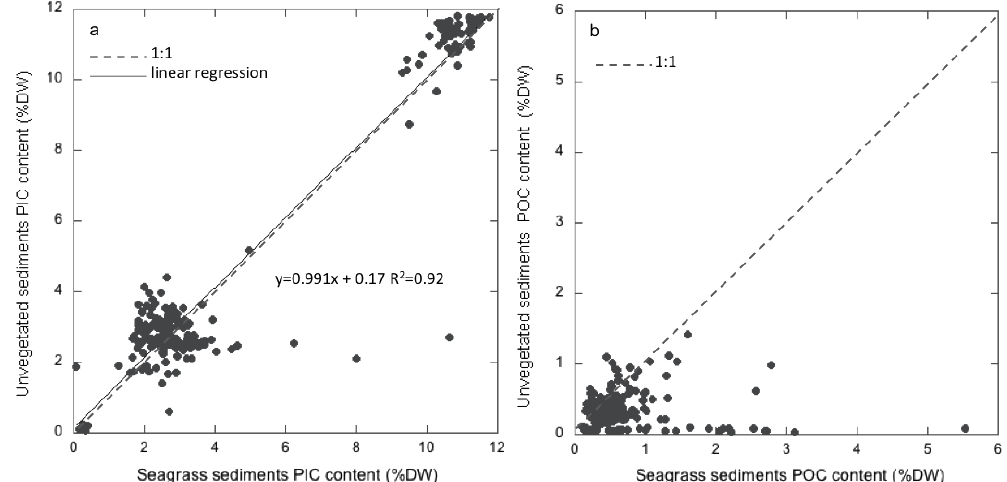
Figure 6. Relationship between (a) PIC content (% DW) in seagrass sediments ( x axis) and adjacent un-vegetated sediments ( y axis) and (b) POC content (% DW) in seagrass sediments ( x axis) and adjacent un-vegetated sediments ( y axis). The dashed line shows the 1 : 1 relationship whereas the continuous line in (a) represents the linear regression model between PIC content (% DW) in vegetated patches vs. adjacent un-vegetated